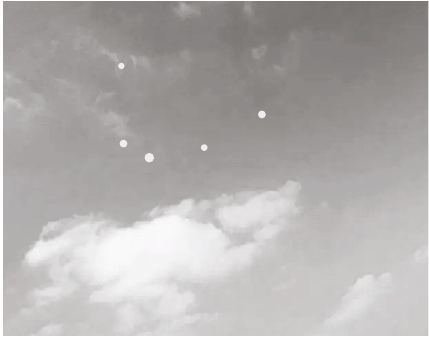
Figure 3: Reference [10] noise reduction results of combination representation learning.